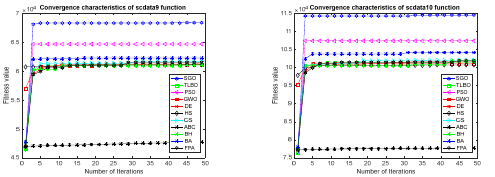
Fig. 5. Convergence characteristics of strongly correlated 0-1 KPs on first 50